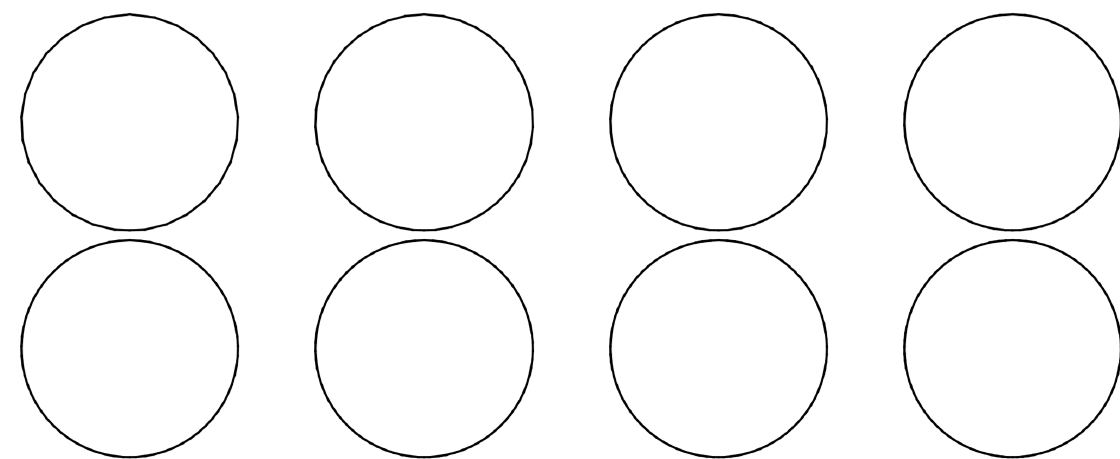
Figure 3. Conjectured largest small polygons 𝐿𝑆𝑃(𝑛) for 𝑛 = 30,40,50,60,70,80,90,100 . Figure 4 summarizes the difference between the area 𝐴(𝑛) of the optimized polygon and 𝜋 4⁄ as a function of 𝑛 , on a loglog-plot scale. Our calculations reveal a small, but non-negligible difference: the numerically estimated slope of the plot for an even number of sides is approximately −2.04618 .